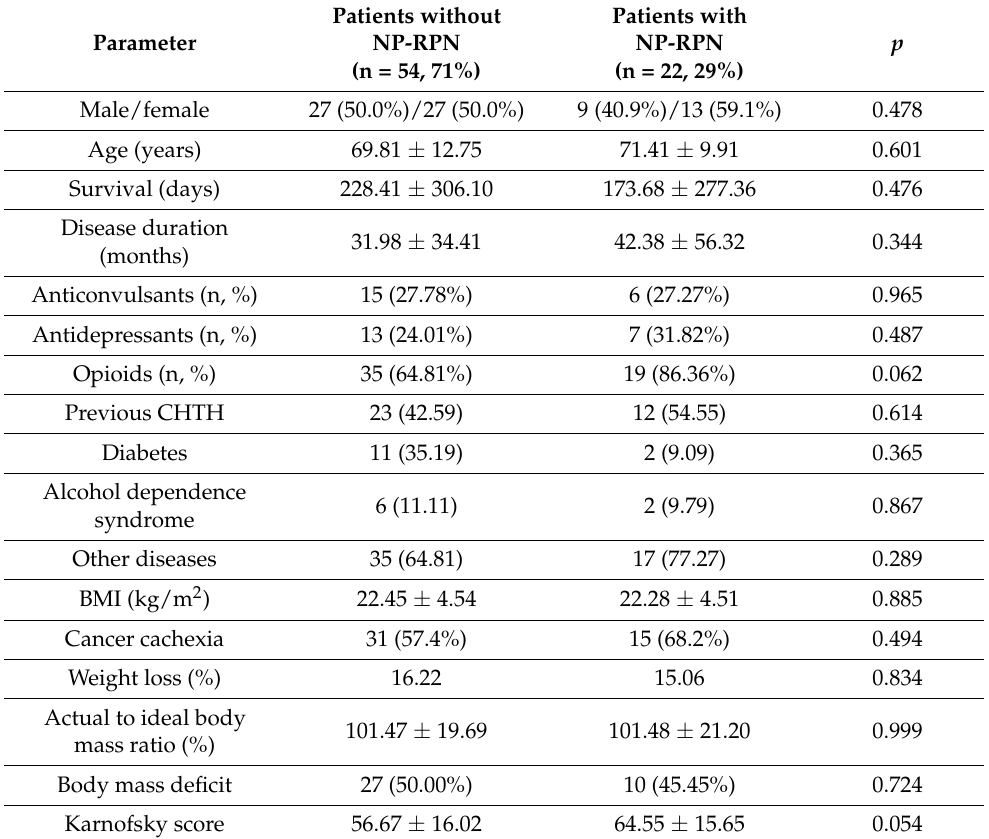
Table 1. Clinical characteristics of hospice patients without and with NP-RPN.